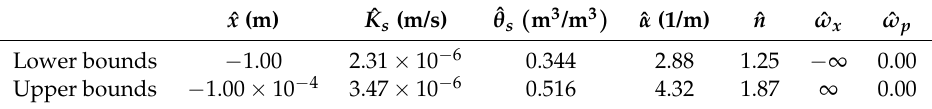
Table 3. Lower and upper bounds used in moving horizon estimation